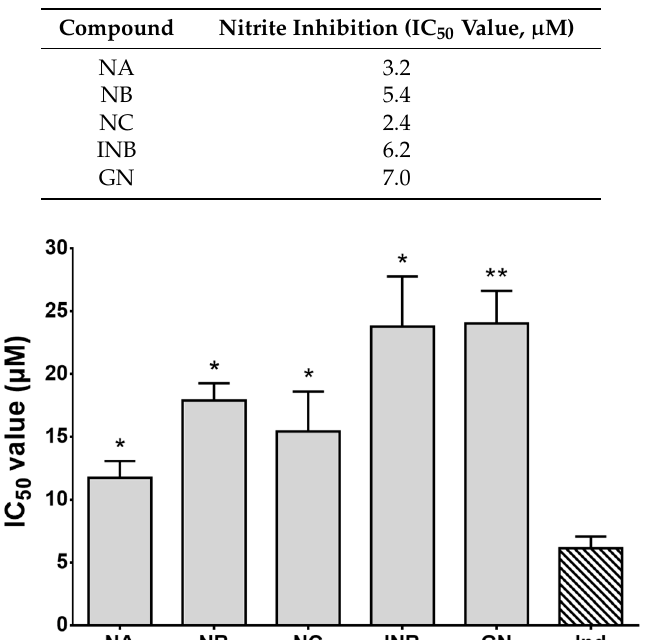
Figure 2. Effects of different compounds on RAW 264.7 cell viability ( A ) and on nitrite formation ( B ) in lipopolysaccharide (LPS)-stimulated RAW 264.7 cells. Ketorolac (Ket) was used as a standard drug. Asterisks indicate significant differences compared to the control (* p < 0.05; ** p < 0.01).